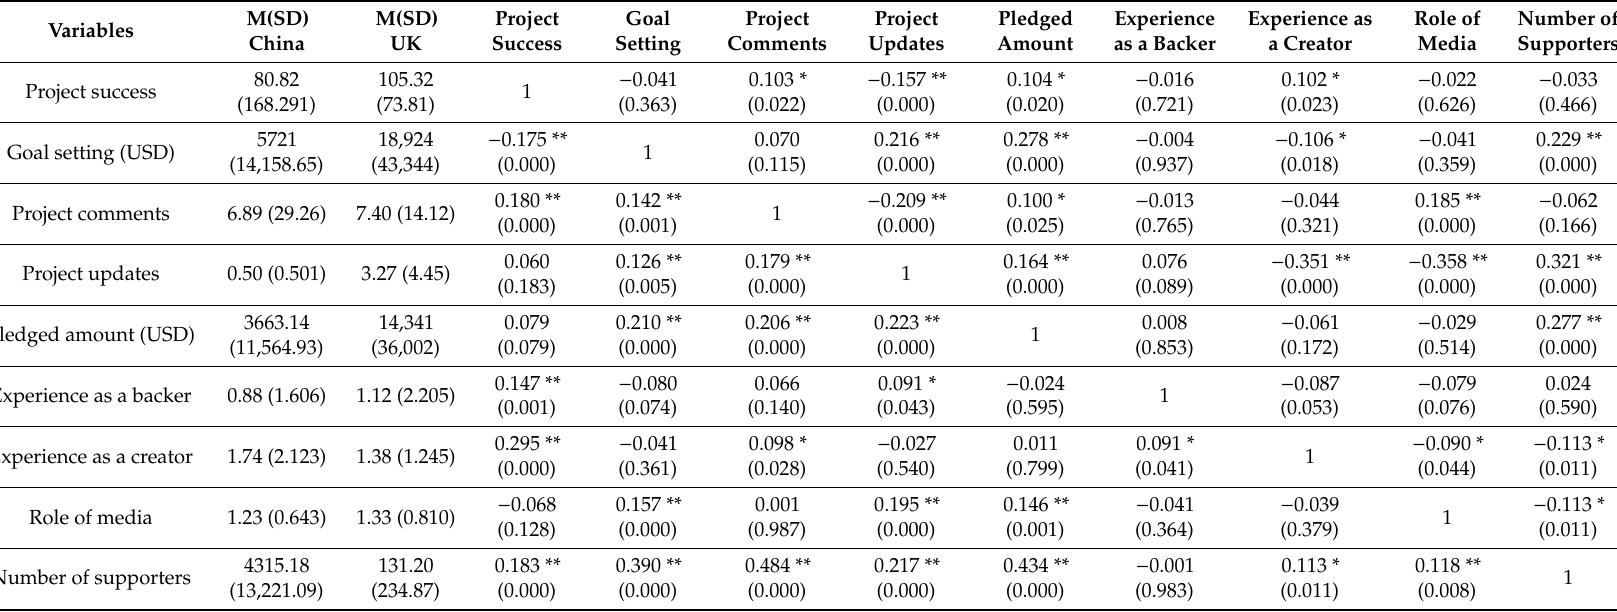
Table 3. Mean, standard deviations and